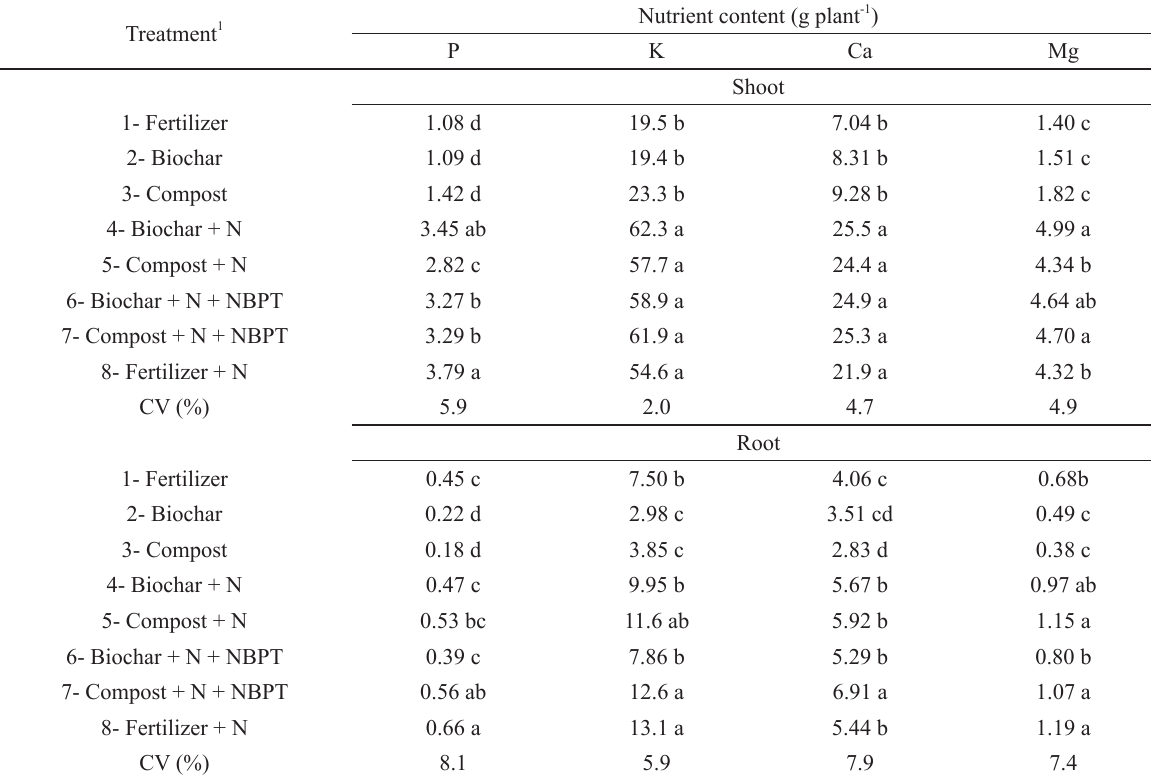
Total nutrient assimilation in maize to soil fertilizer, compost and biochar additions combined with urea and NBPT. Treatment